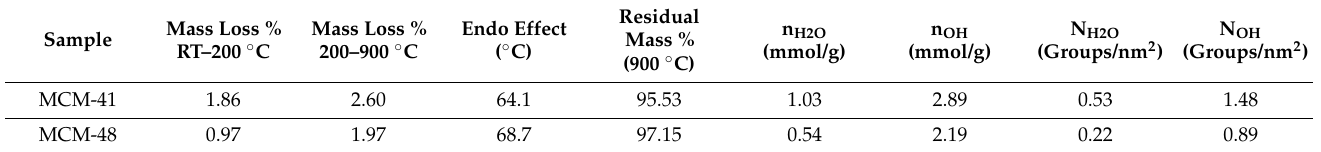
Table 3. MCM-41 and MCM-48 characteristics from the TGA and BET